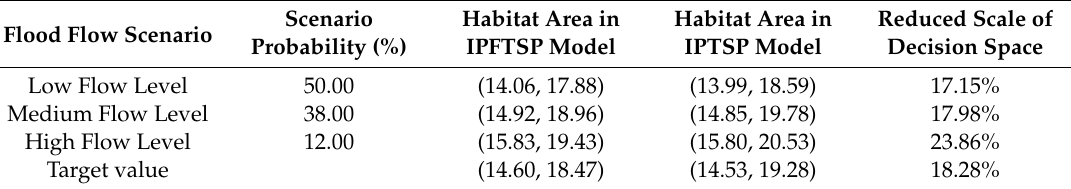
Table 4. The recovered habitat area in the IPFTSP and IPTSP models under different flood flow scenarios (10 3 ha).